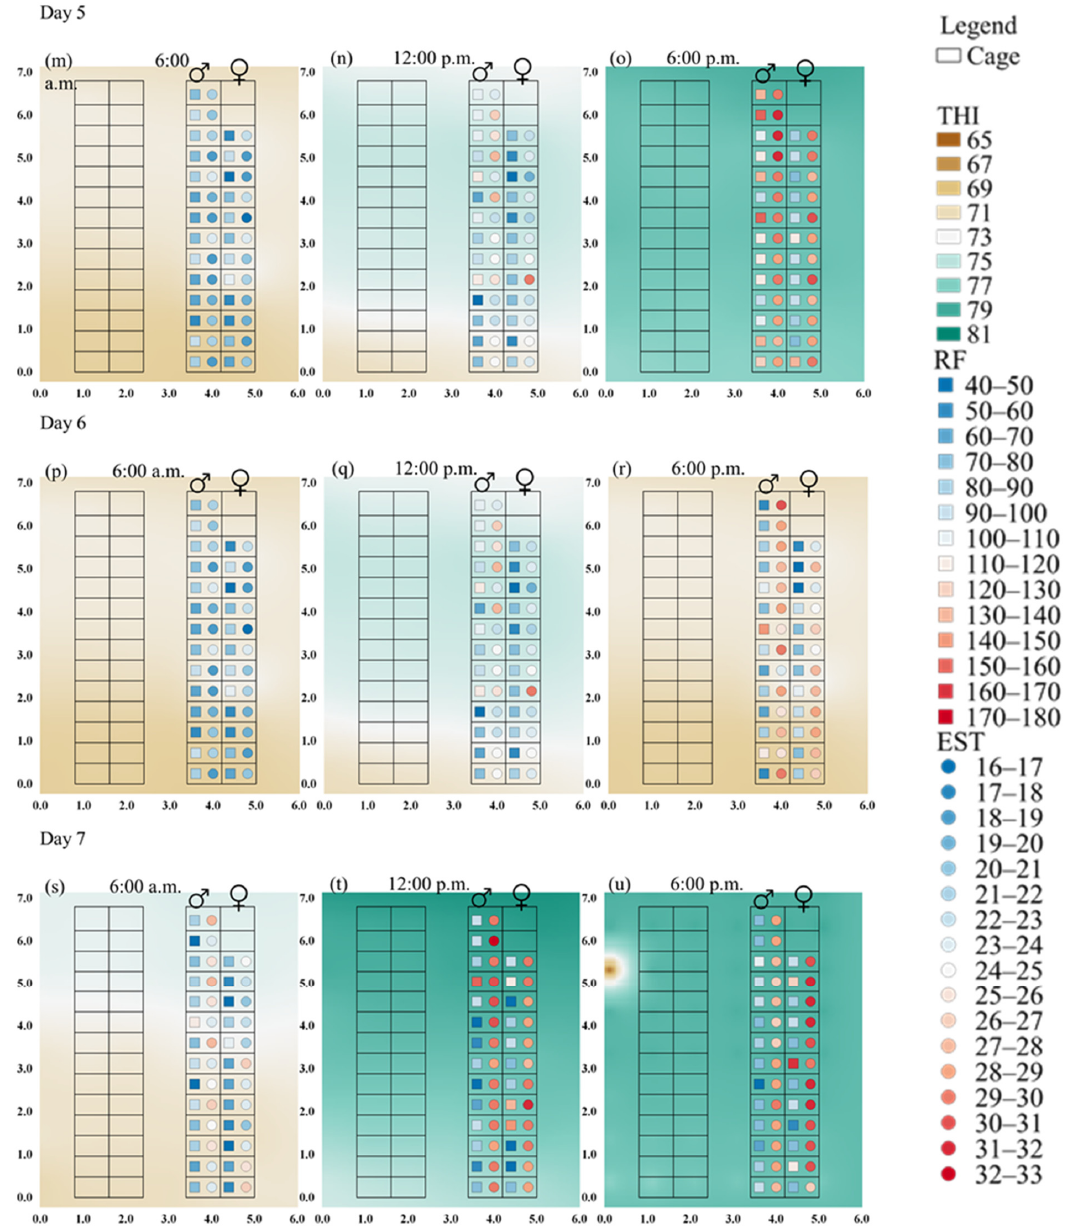
Figure 2. Spatial distribution of the temperature and humidity index (THI), respiratory frequency (RF, breaths.min − 1 ), and ear surface temperature (EST, °C) of New Zealand white (NZW) rabbits at 6:00 a.m., 12:00 p.m., and 6:00 p.m. over seven days inside a rabbit house.